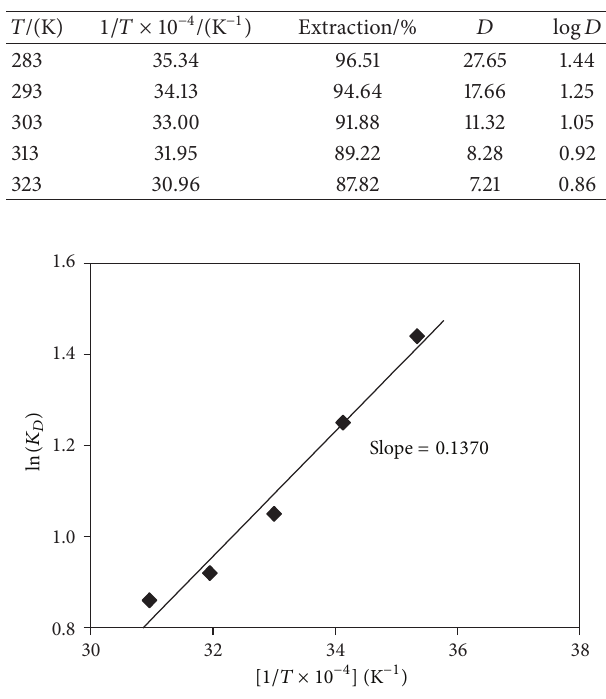
Table 3: Effect of temperature on Te(IV) extraction.